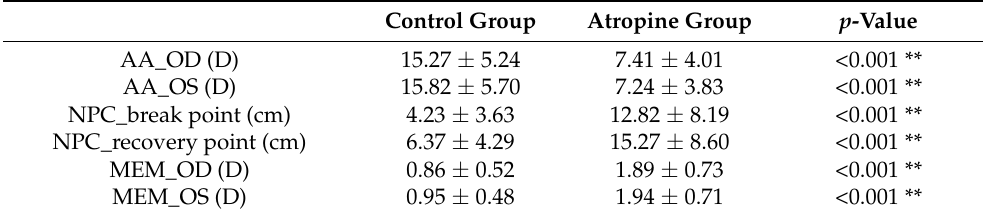
Table 2. The comparison of accommodative responses and near point convergence between the atropine group and the control group.